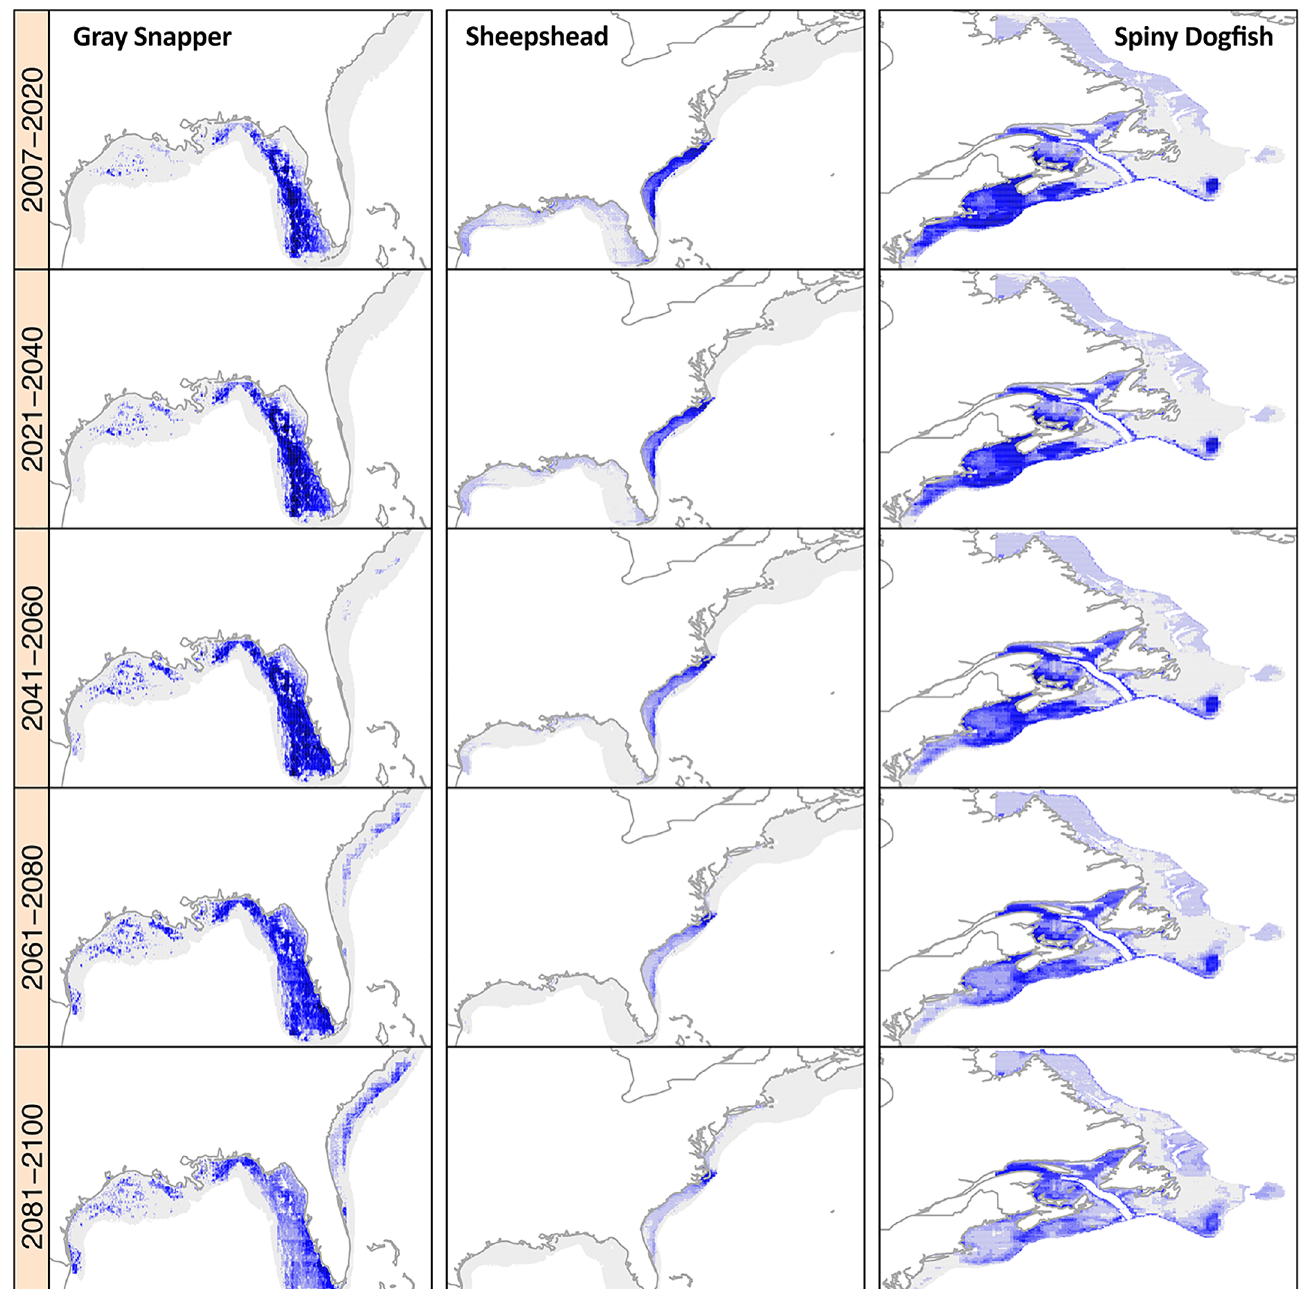
Fig 8. Examples of east coast species projections. Gray snapper Lutjanus griseus is in the left-most column, sheepshead Archosargus probatocephalus is in the middle column, and spiny dogfish Squalus acanthias is in the right-most column. For other details, refer to Fig 7